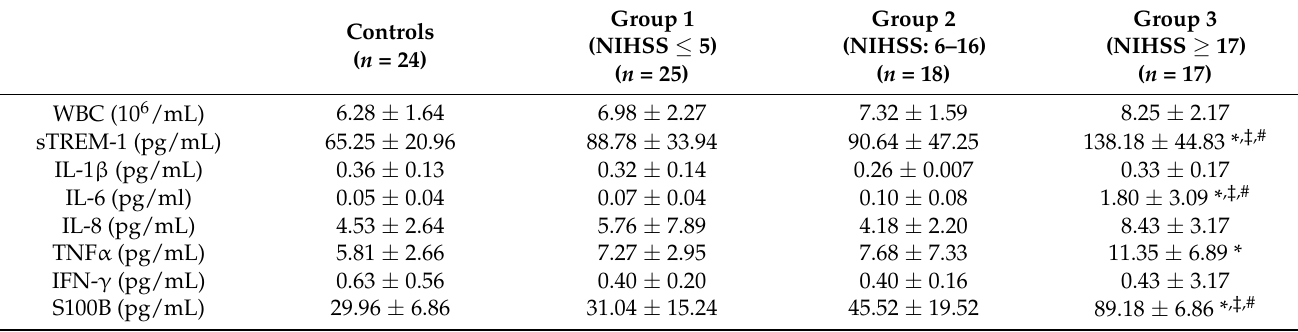
Table 3. Comparisons of WBC, sTREM-1, proinflammatory cytokines, and S100B in terms of the NIHSS in acute ischemic stroke.